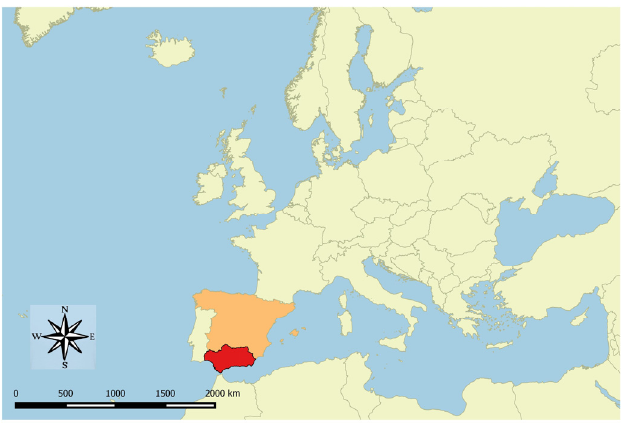
Figure 1. Andalusia location map.